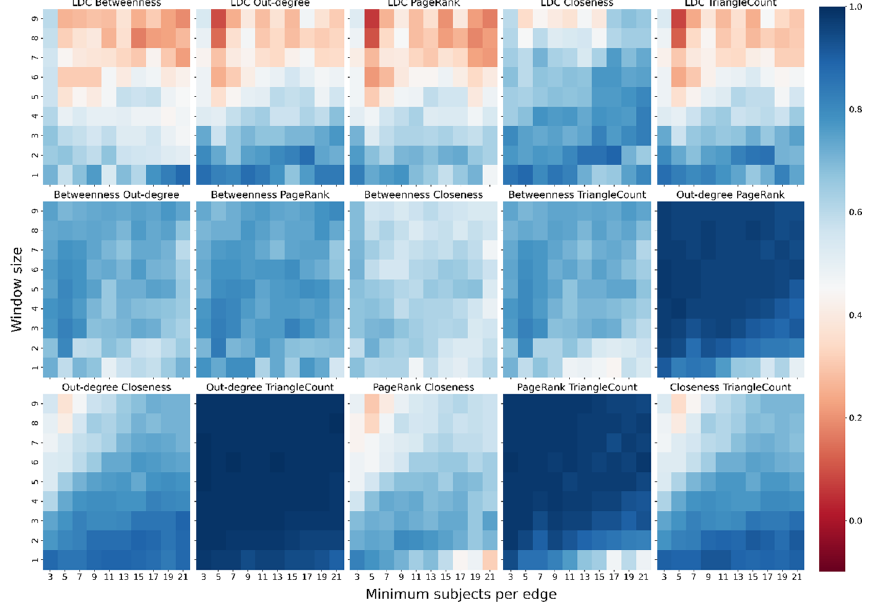
Fig. 3 Correlations between pairs of centrality measures. Each plot represents a correlation matrix between a pair of measures. The x-axis denotes the range of MS values, and the y- axis denotes the range of WS values. The color highlights the sign and magnitude of Spearman coefficients. The redder a cell is, the closer the correlation is to zero. The bluer a cell is, the closer the correlation is to